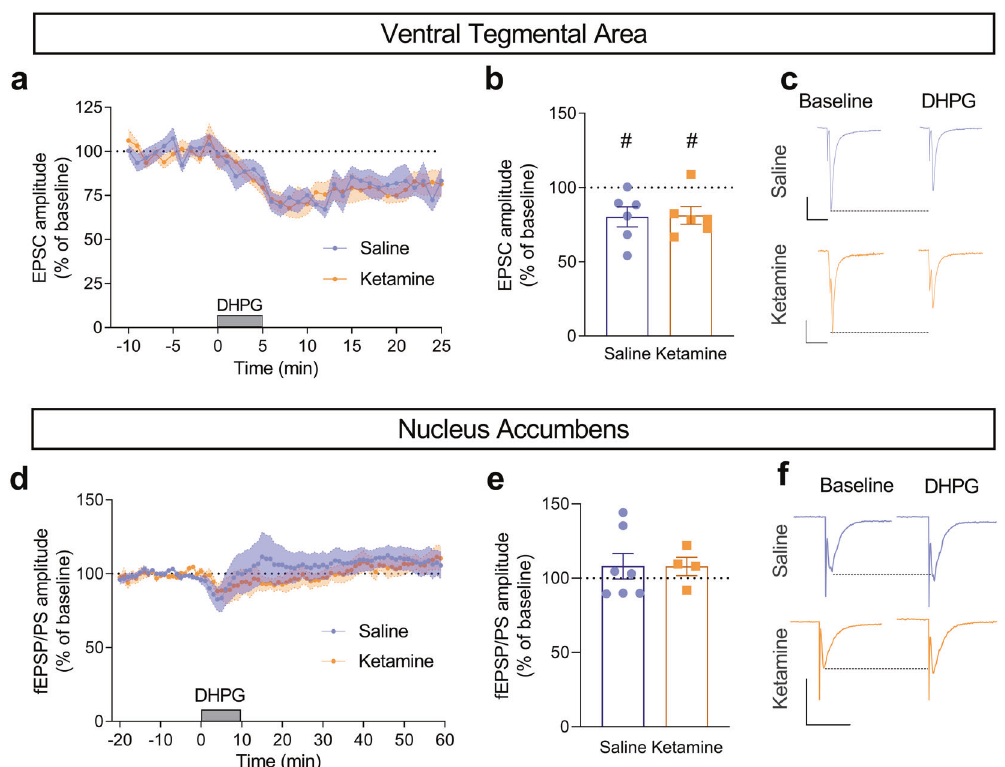
Fig. 3 Effect of DHPG on glutamatergic synaptic transmission is not altered by ketamine. a , d Time course of the effect of bath application of DHPG ( a : 20 μ M; b: 100 μ M), a group I mGluR agonist, on the amplitude of AMPAR-EPSCs in VTA DA neurons ( a ) and fEPSP/PS in the NAc ( d ) in saline- and ketamine-treated mice. b , e Percent of baseline in VTA DA neurons ( b ): saline 80.3 ± 6.8 ( n = 6 neurons from 4 mice), ketamine 81.2 ± 5.9 ( n = 6 neurons from 3 mice). # P = 0.0332 and 0.0252 paired t -test. P = 0.9169 unpaired t -test. Percent of baseline in the NAc ( e ): saline 108.0 ± 8.6 ( n = 7 slices from 4 mice), ketamine 107.9 ± 6.2 ( n = 4 slices from 3 mice), P = 0.9917 unpaired t -test. c , f Example traces of AMPAR- EPSCs before (baseline) and during the application of DHPG in the perfusion solution in VTA DA neurons ( c ). Scale bars: 100 pA/20 ms for